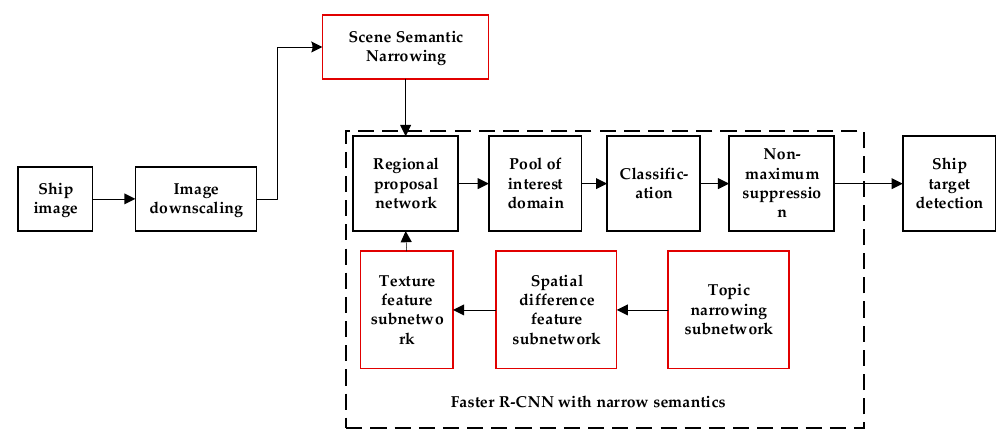
Figure 2. Flow chart of the method.